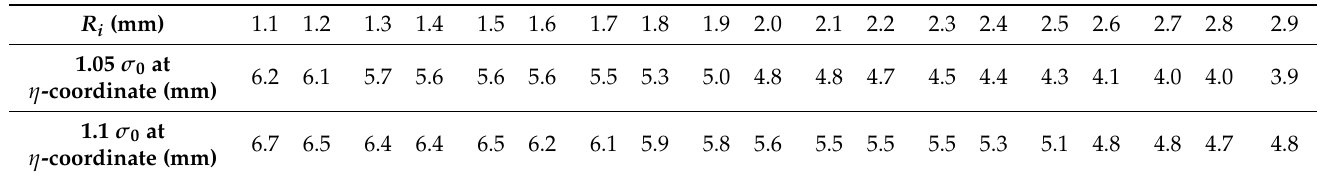
Table 2. In geometry B with an external radio R e = 1 mm and internal radius R i between 1.1 mm and 2.9 mm: η -coordinate at which the maximum principal stress along the path takes the values of 1.05 σ 0 and 1.1 σ 0 .